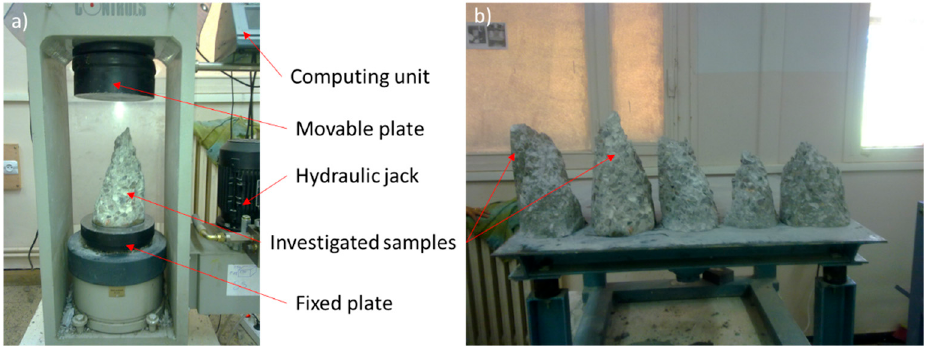
Figure 2. View of the investigated samples: ( a ) in the test stand during the test and ( b ) failure models after the tests.